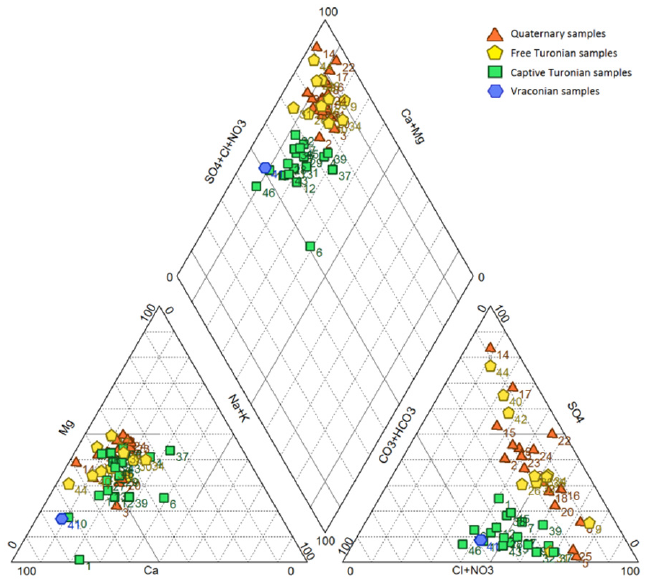
Figure 7. Piper diagram. Major-ion relationships in groundwater in BouSbaâ Basin.